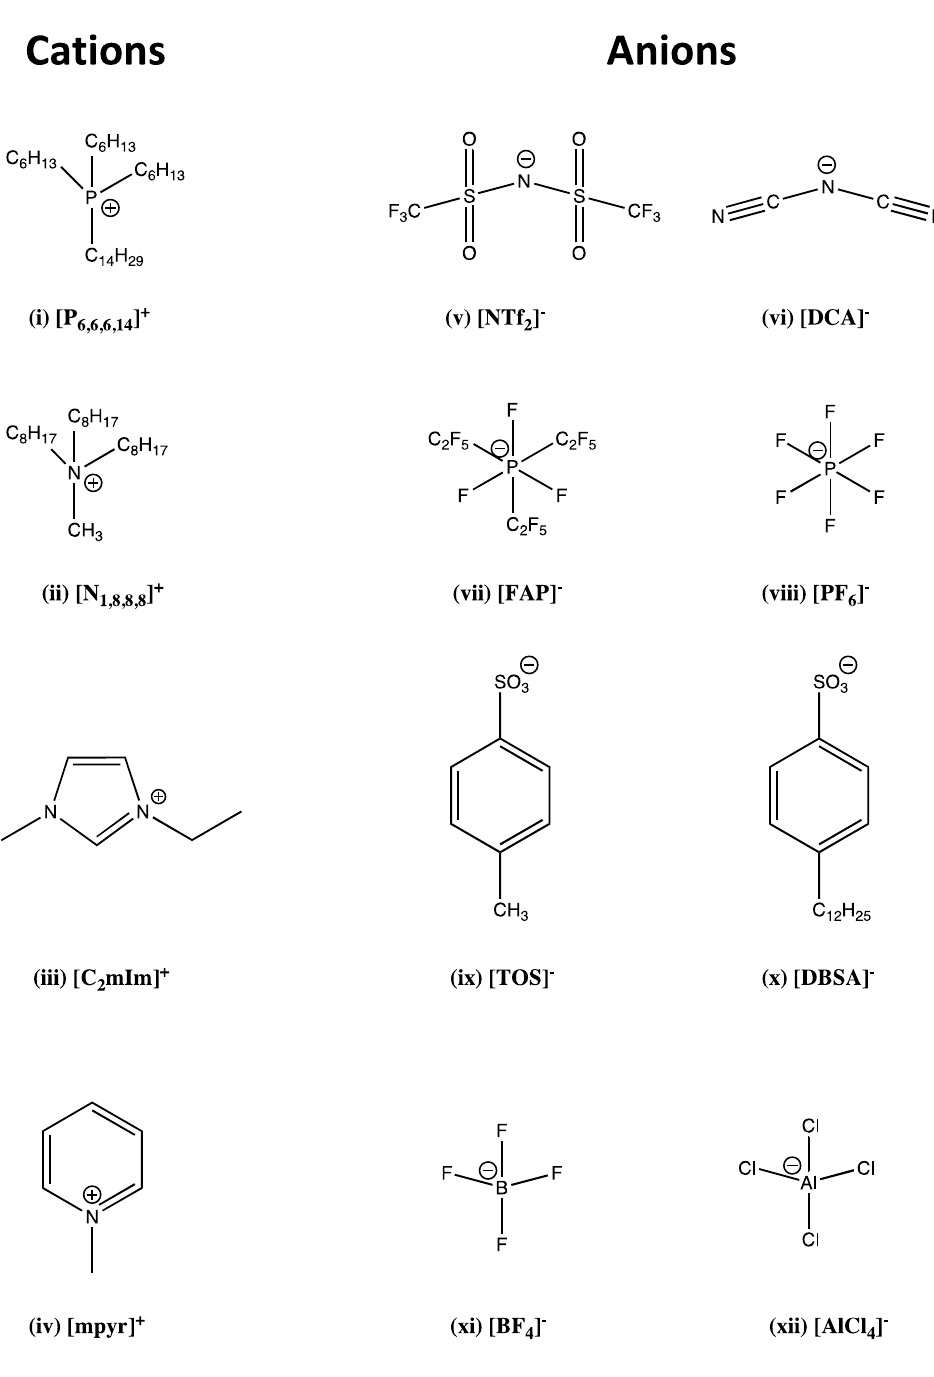
Figure 2. A list of the more popular ions used throughout the literature for IL syntheses. Cations are listed on the left [(i)–(iv)], and anions are listed on the right